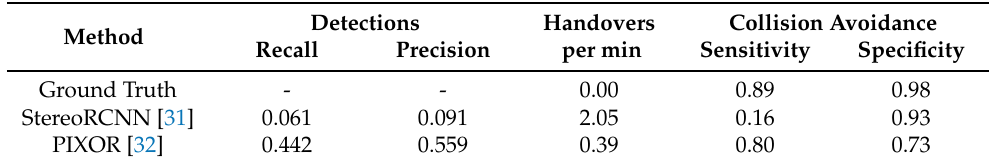
Figure 11. Example bounding box predictions from two different detectors. ( a ) StereoRCNN uses two stereo images to compute 3D (red) and 2D (blue) bounding boxes around other RACECARS. ( b ) PIXOR detector uses Velodyne point clouds as inputs to predict RACECARS 3D bounding boxes (blue). Table 1. Evaluation of object detectors in the